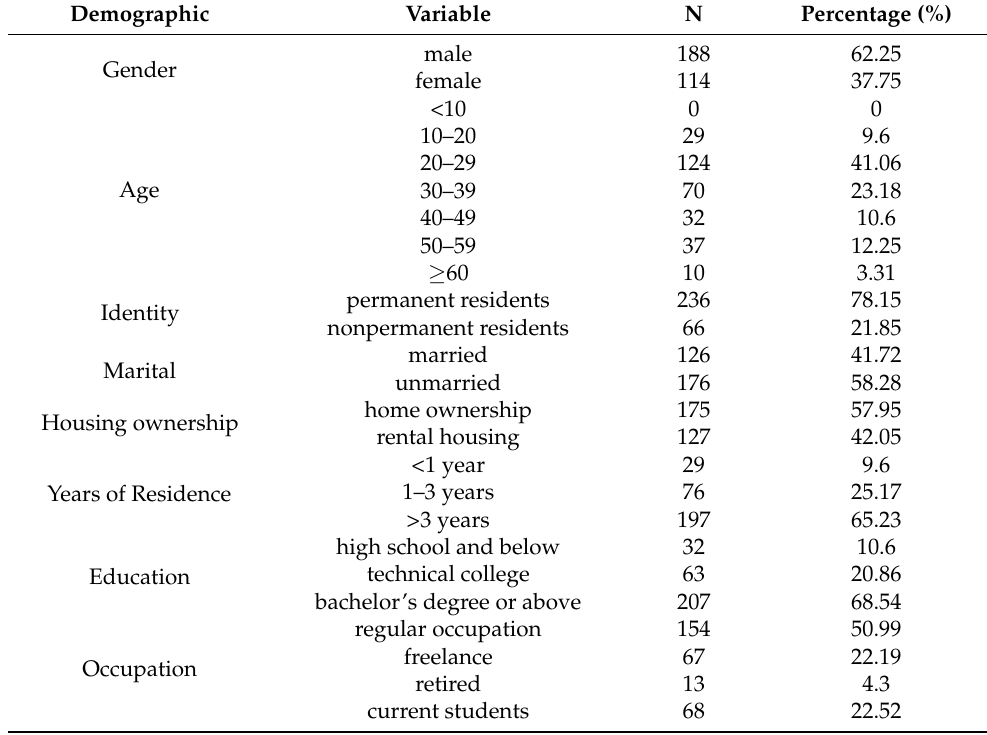
Table 3. The statistical results on the sociodemographic characteristics of the